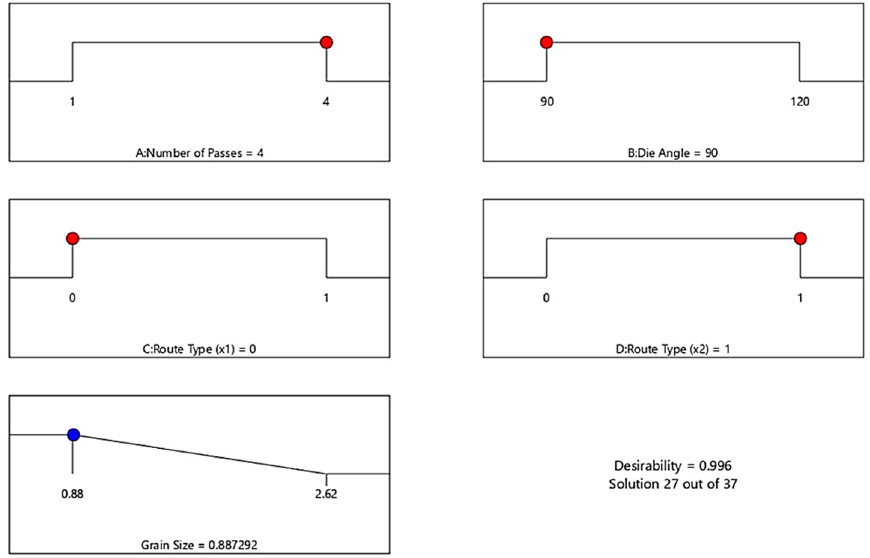
Figure 11. Optimal ECAP process parameter of G R . Red dots: ECAP condition. Blue dots: ECAP response.